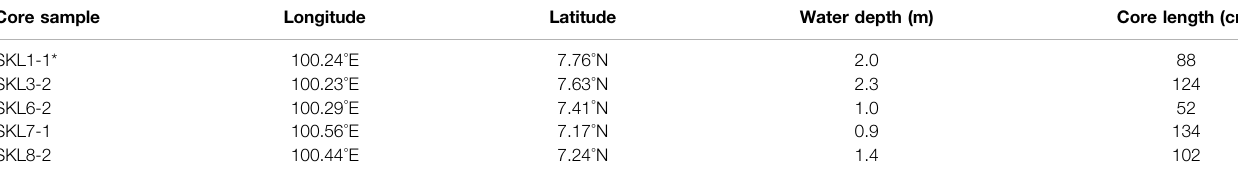
TABLE 1 | Information on fi ve core samples from Songkhla